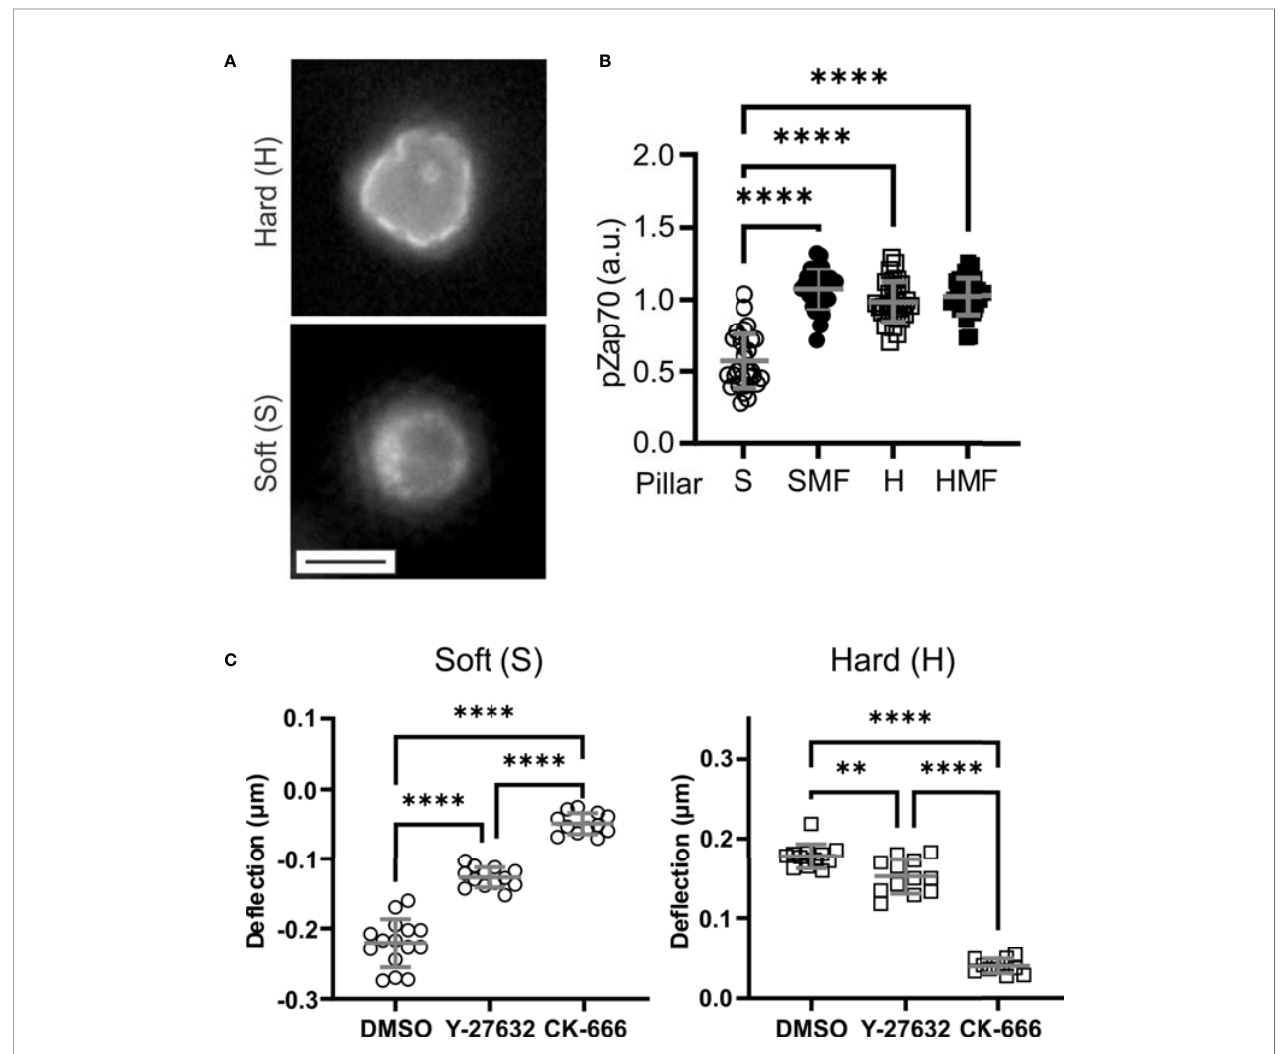
FIGURE 3 | Molecular mechanisms of T cell mechanosensing. (A) Distribution of phsopho-Zap70 (Tyr 319). Cells were fi xed 15 minutes after seeding. These images illustrate a plane through cells at the pillar tips. Scale bar = 5 µm. (B) Quantitative comparison of pZap70. Each data point represents an individual cell, and bars report mean ± s.d., from at least 30 cells per condition from 3 independent experiments. Only signi fi cant comparisons with the Soft (S) condition are indicated; additional comparison are reported in the main text. (C) Effect of inhibitors of cytoskeletal dynamics on pillar de fl ection. Each data point represents an individual cell, and bars report mean ± s.d., from at least 15 cells per condition from 3 independent experiments. DMSO = vehicle control for both inhibitors. For all panels, data were analyzed by one way ANOVA; **P < 0.01, ****P <